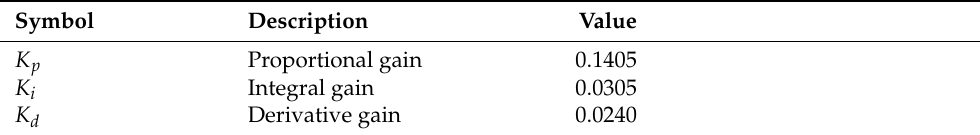
Table 7. Tuned parameters of PID controllers using the Ziegler–Nichols method for angular tracking. Symbol Description Value K p Proportional gain 0.1405 K i Integral gain